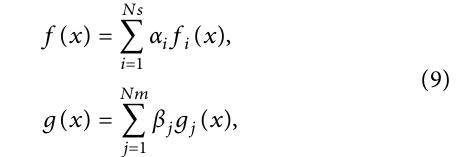
Figure 5: The simulation